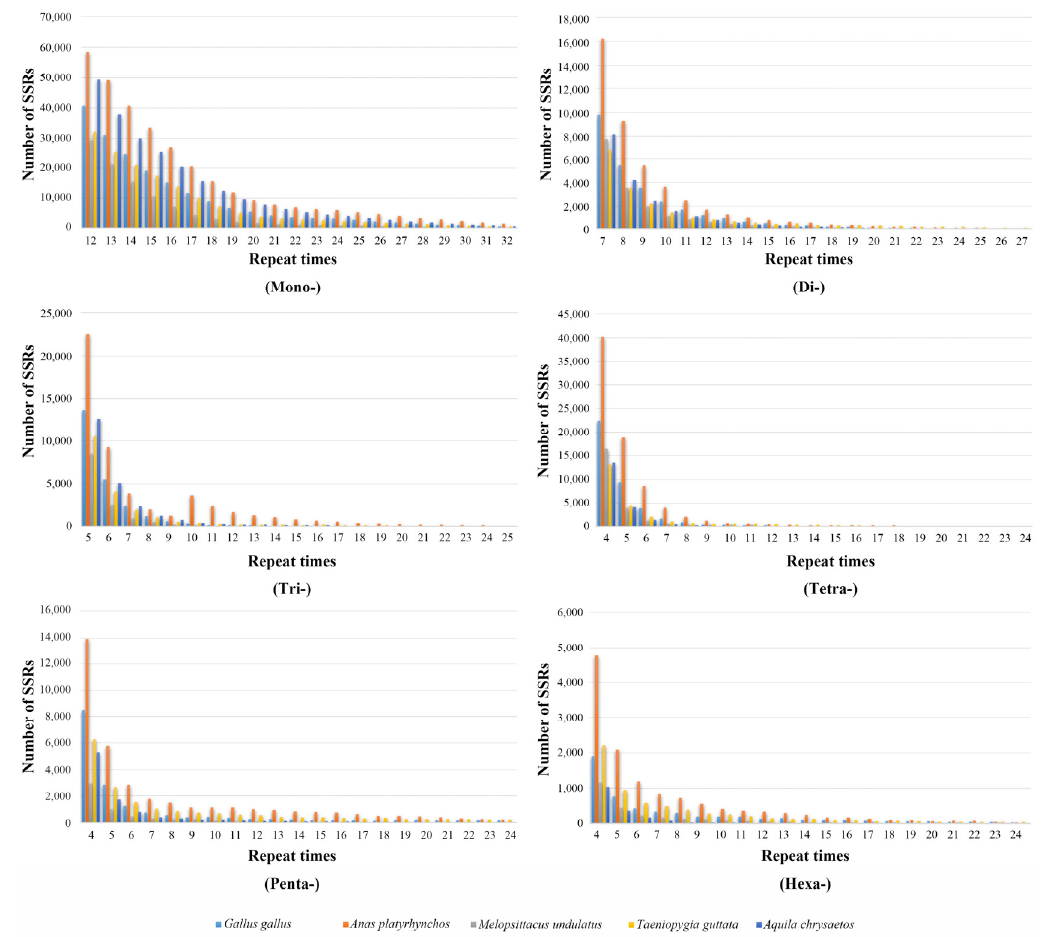
Figure 6. Relationship between repeat times and number of P-SSRs.